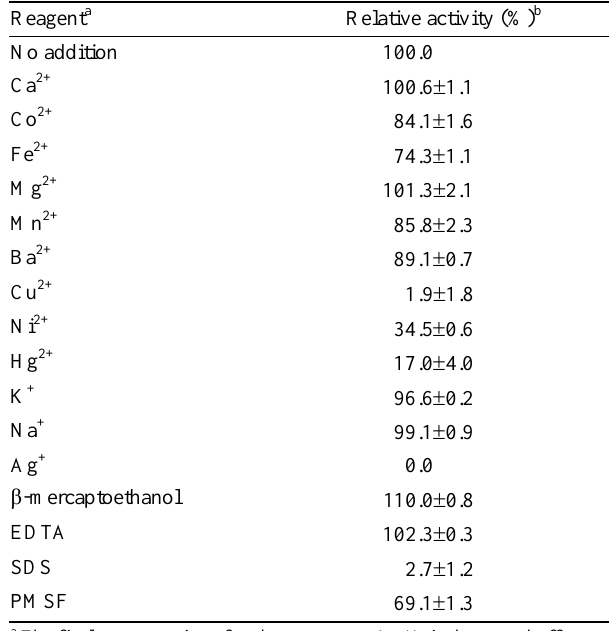
Table 1. Effect of metal ions and chemicals on LX-20  -